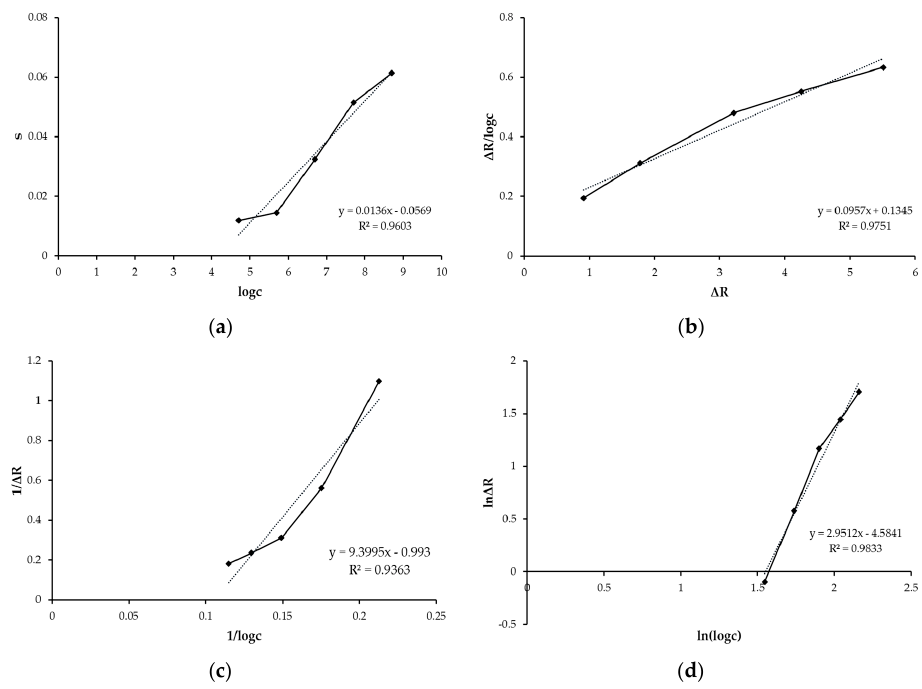
Figure 6. Adsorption isotherm models: ( a ) Association, ( b ) Scatchard, ( c ) Langmuir and ( d ) Freundlich.